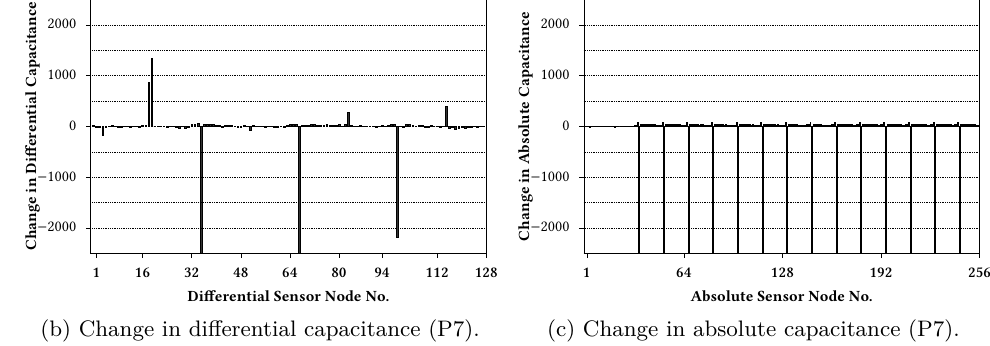
Figure 23: Attack Profile 7 (P7): Using drill of 300 µ m with subsequent